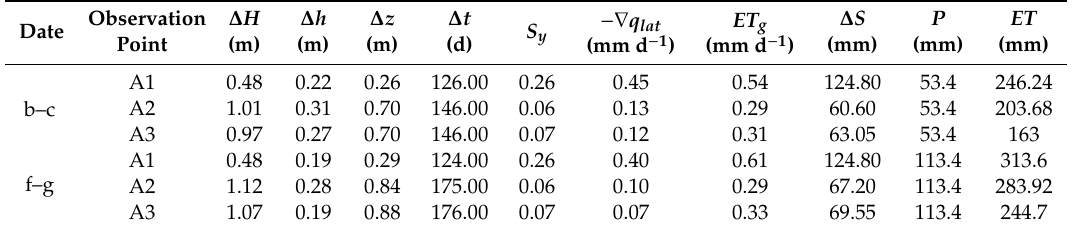
Table 5. Statistical table of water-balance parameters in the growth